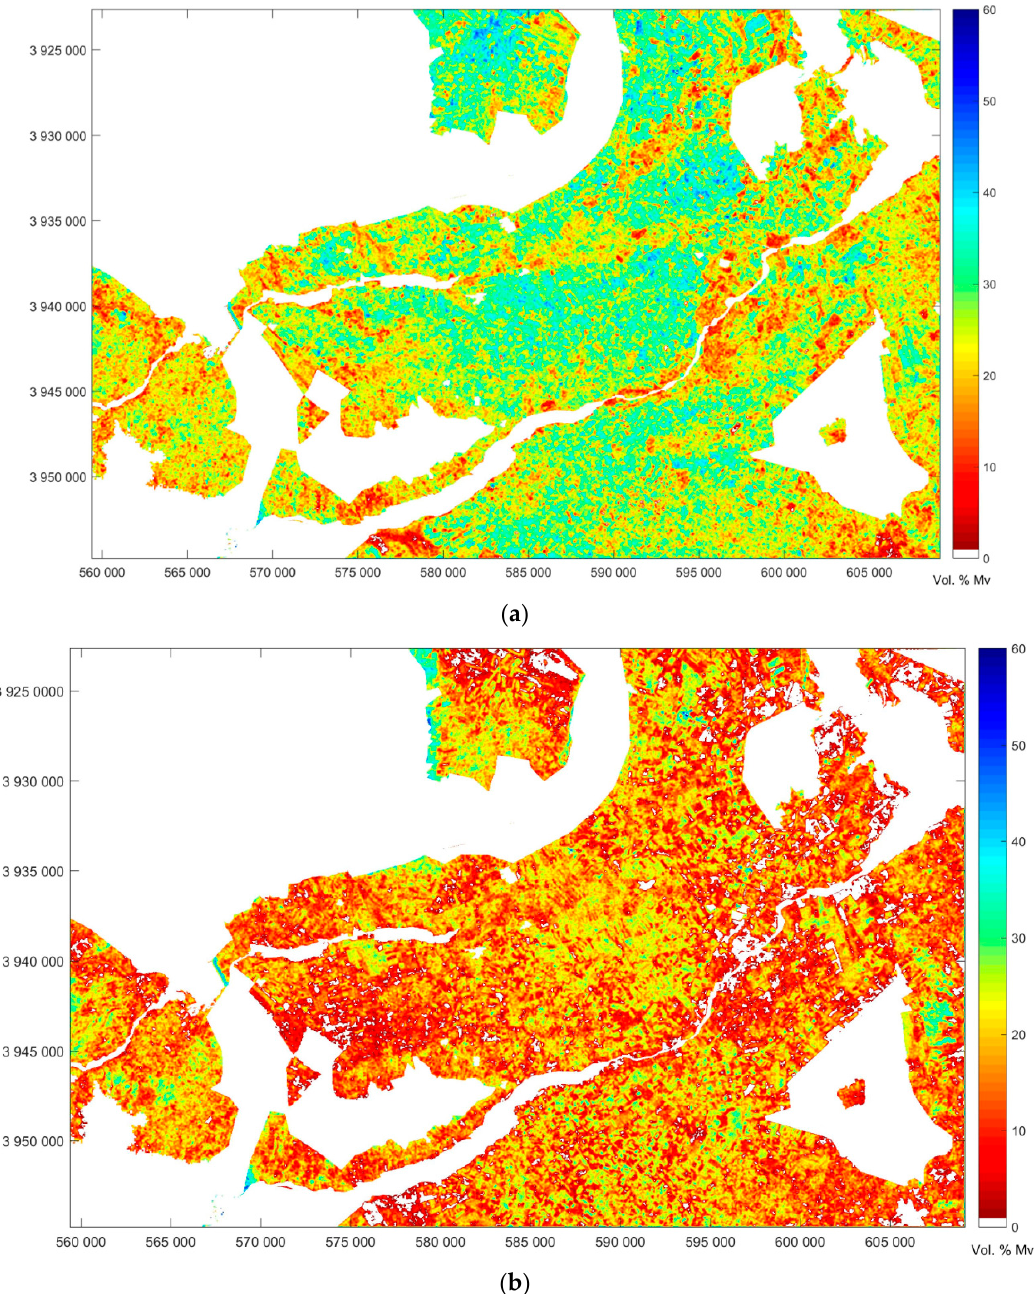
Figure 8. Soil moisture maps over the study site on two different dates: 24 December 2016 ( a ) and 20 July 2016 ( b ).